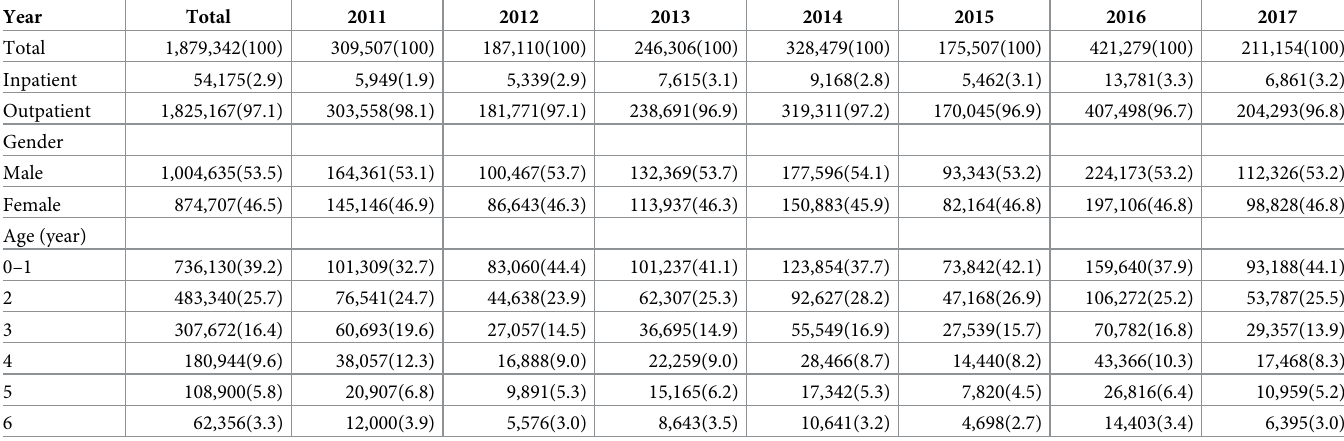
Table 1. The epidemiological characteristics of HFMD cases (%) in Korea,